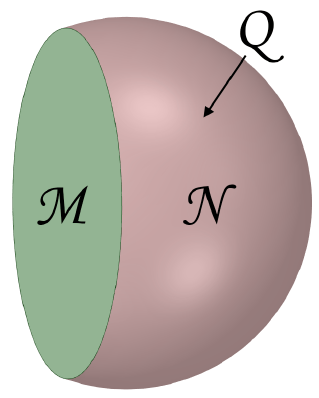
Figure 3 . A schematic representation of the AdS/BCFT prescription: the BCFT is defined on a manifold M with a boundary, and the dual spacetime manifold N is cut off by an ETW brane Q homologous to M